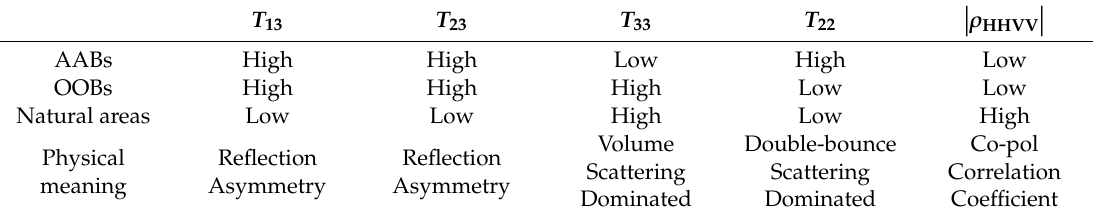
(cid:12) (cid:12) (cid:12) (cid:12) (cid:12) ρ HHVV (cid:12)